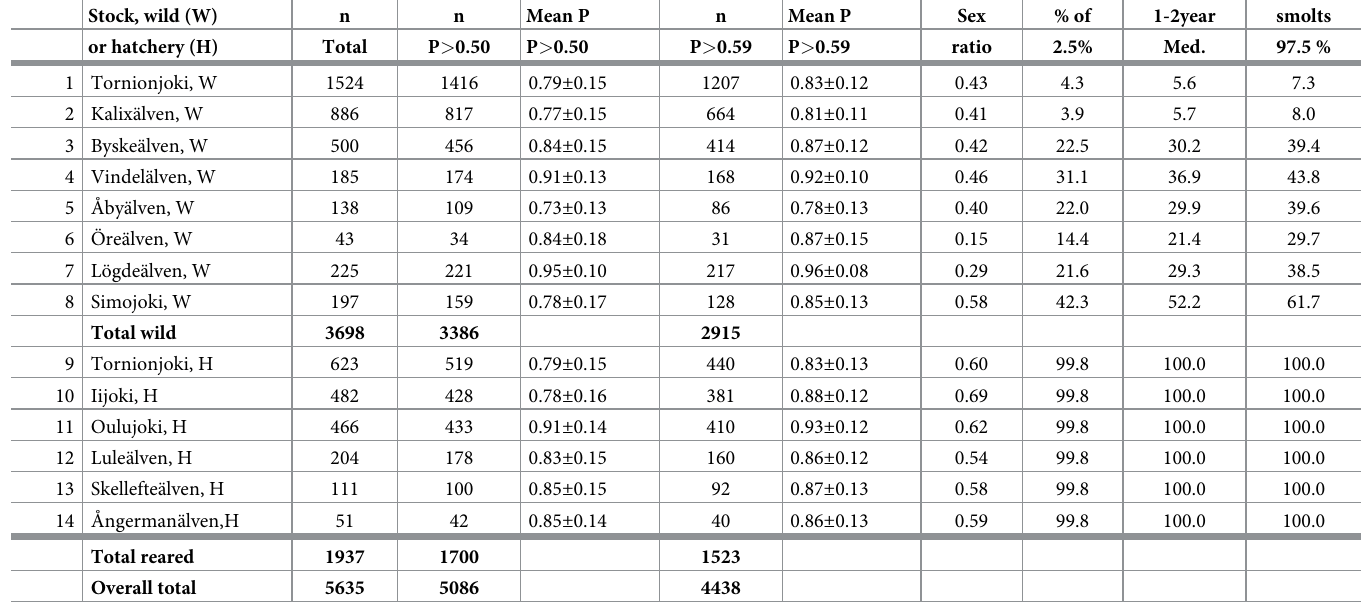
Table 1. Mean probability of the stock of origin for the individually assigned catch fish from the Atlantic salmon offshore catches in the Bothnian Bay during 2000–2013. Stock, wild (W)